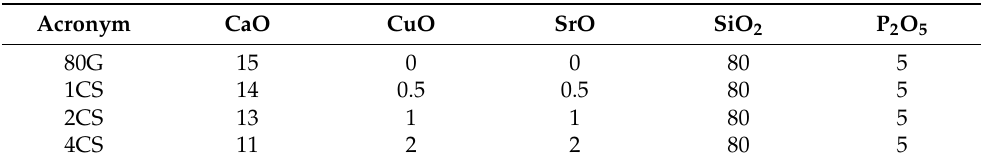
Table 4. The theoretical (nominal) compositions of the glass (in mol.%) and the acronyms used to indicate